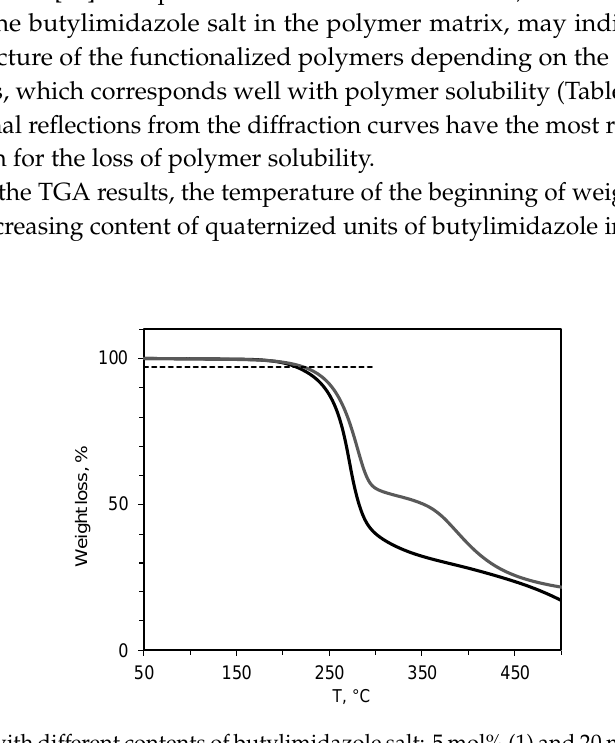
Table 4. Gas permeability, solubility and diffusion coefficients of membranes containing butylimidazole salt in the polymer matrix.